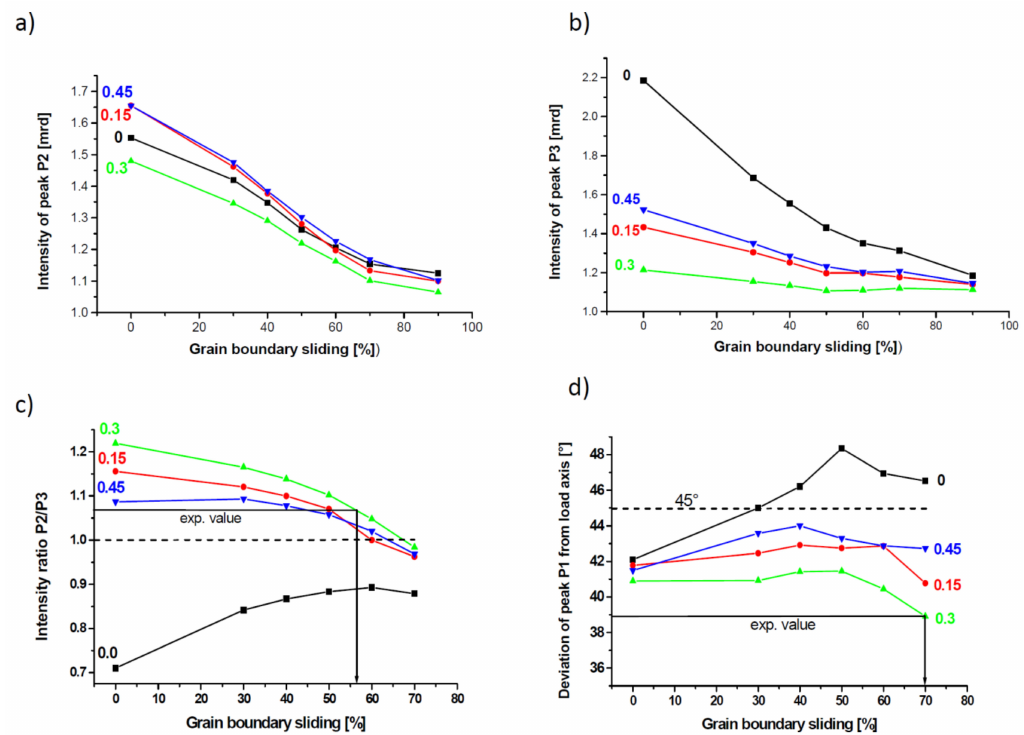
Figure 3. Dependence of the peak intensities P2 ( a ) and P3 ( b ), intensity ratio P2/P3 ( c ), and angular deviation of Peak P1 from the load axis ( d ) on the contribution of GBS to strain with the fraction of compressive strain as parameter. In (c,d), the amount of GBS is estimated from the experimentally measured